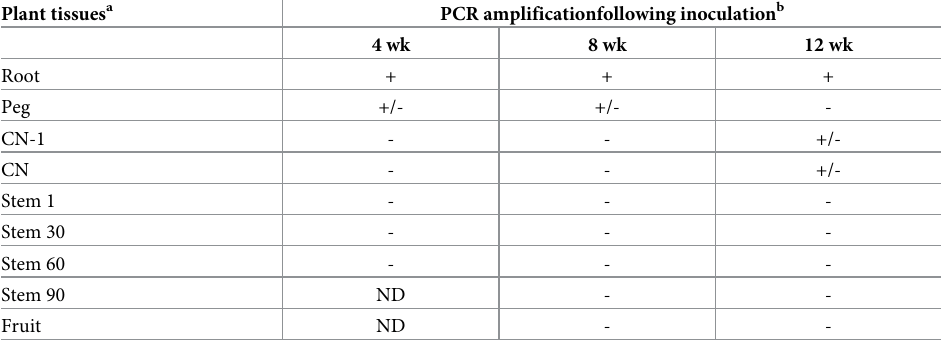
Table 4. Distribution of HOFo isolate MCC2074 in tomato plant tissues based on specific primers Primer 5/ ST33-R following soil infestation inoculation. Plant tissues a